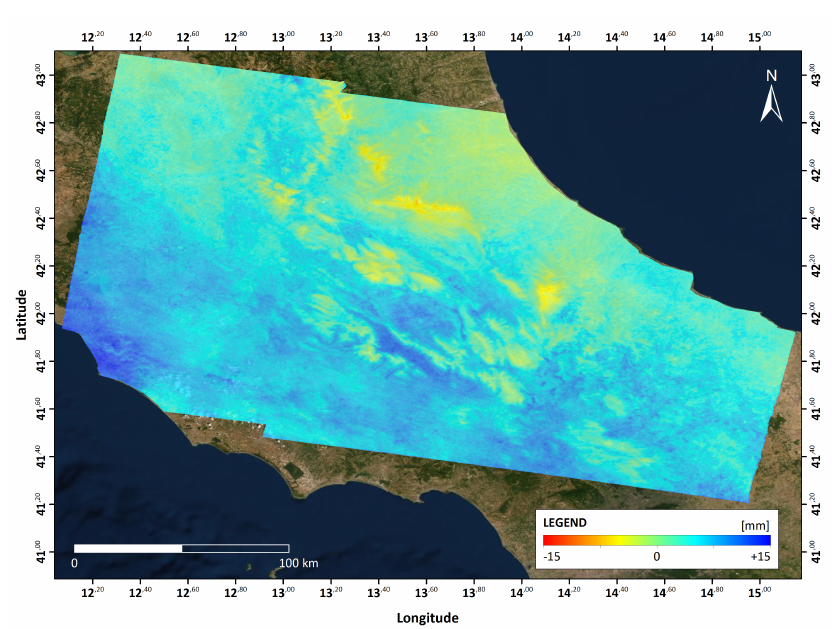
Figure 7. Silvi Marina AOI: example of Atmospheric Phase Screen [mm/year] on the